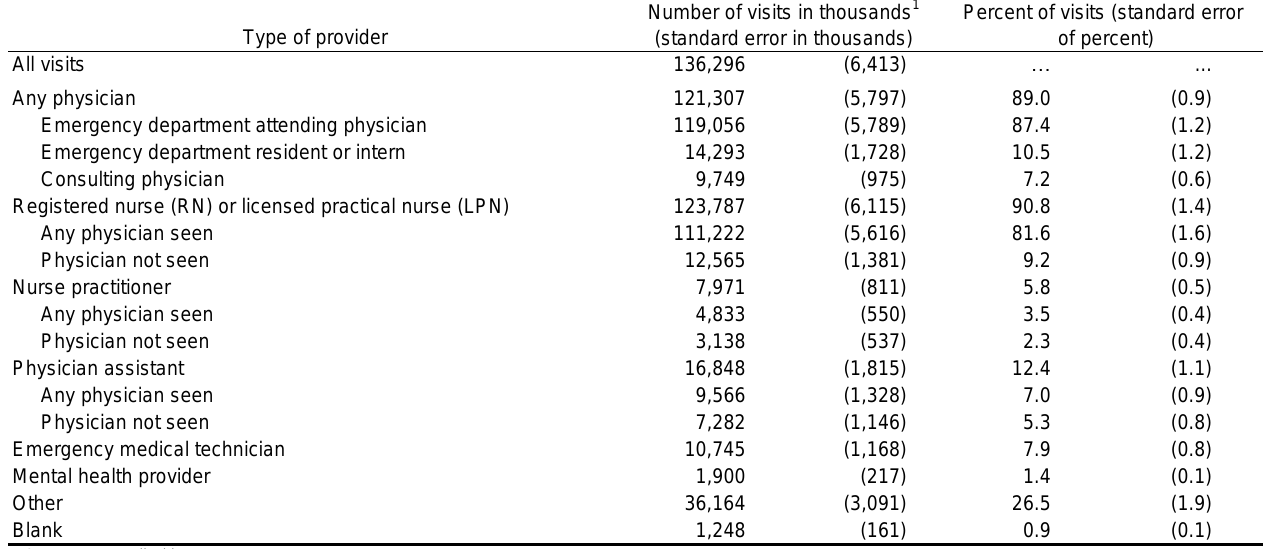
Table 23. Providers seen at emergency department visits: United States, 2011